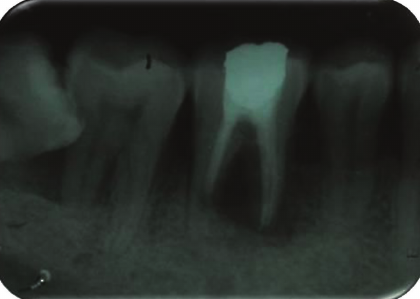
Figure 2: Intentional RCT done.